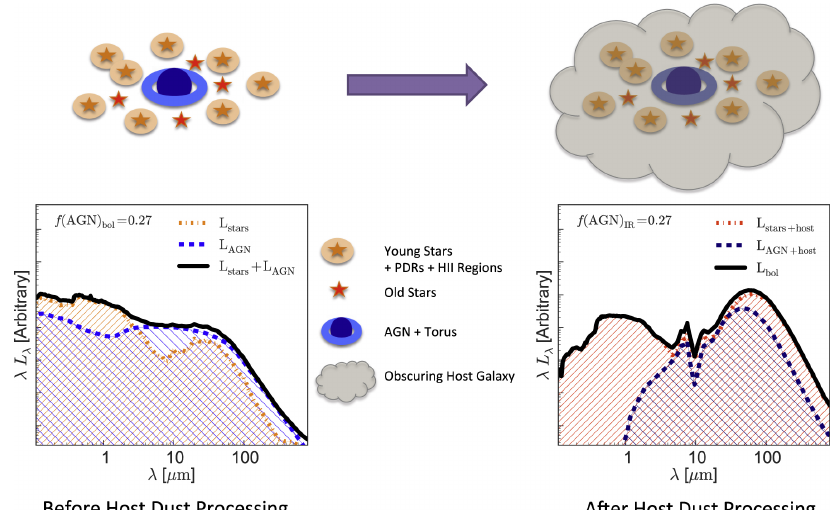
Figure 15. An illustration, based on the coalescence stage of a gas-rich major merger simulation, of how the light from the AGN+dusty torus can be further modified by the dust of the host galaxy and lead to a much larger contribution of the AGN to the total IR emission of the galaxy than treatments not accounting for dust host galaxy obscured suggest. Reproduced with permission from Roebuck et al. [180], AAS ©